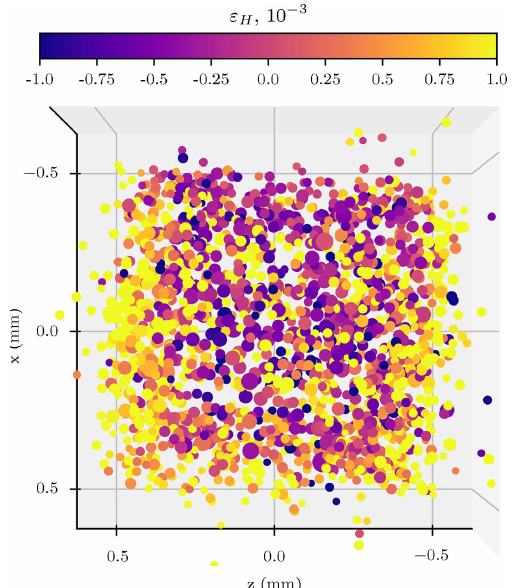
Figure 8 Stitched grain centre-of-mass map of DX54 steel, looking down y (top) with grains coloured by the mean of the diagonal elements of the lattice distortion tensor, " H .